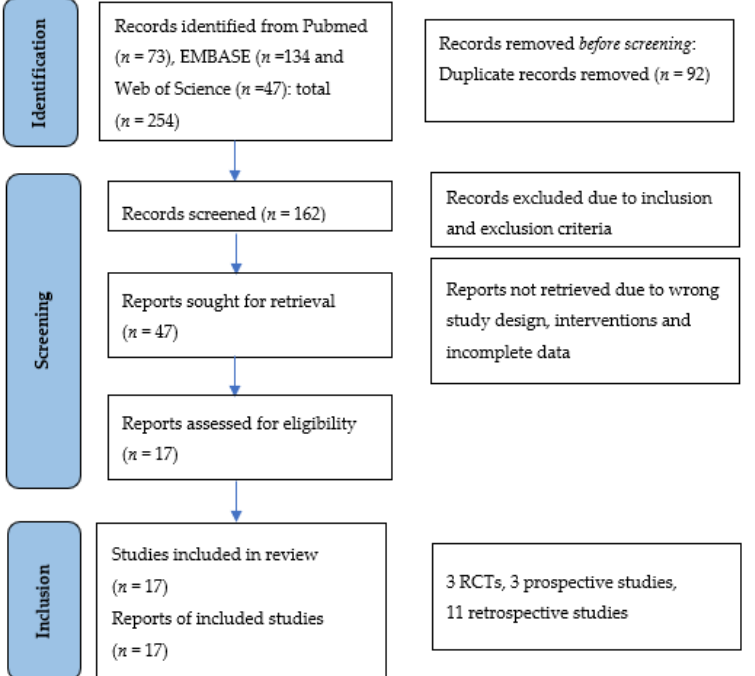
Figure 1. PRISMA flowchart for study selections. A total of 17 studies were included in our meta- analysis; of which 3 were randomized controlled trials (RCTs), 3 were non-randomized clinical trials, and 11 were retrospective studies. From: Page MJ, McKenzie JE, Bossuyt PM, Boutron I, Hoffmann TC, Mulrow CD, et al. The PRISMA 2020 statement: an updated guideline for reporting systematic reviews. BMJ 2021;372:n71. doi: 10.1136/bmj.n71.